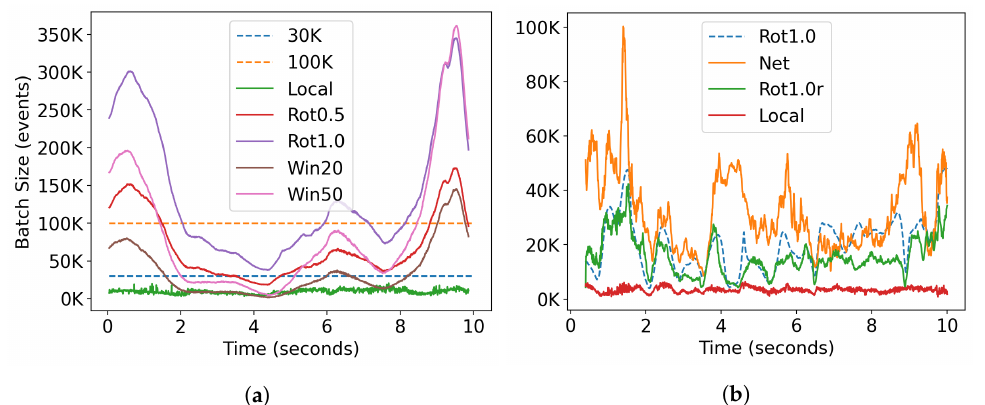
Figure 6. Batch sizes for different batch selection strategies: ( a ) arch1_1 dataset and ( b ) room dataset (first 10